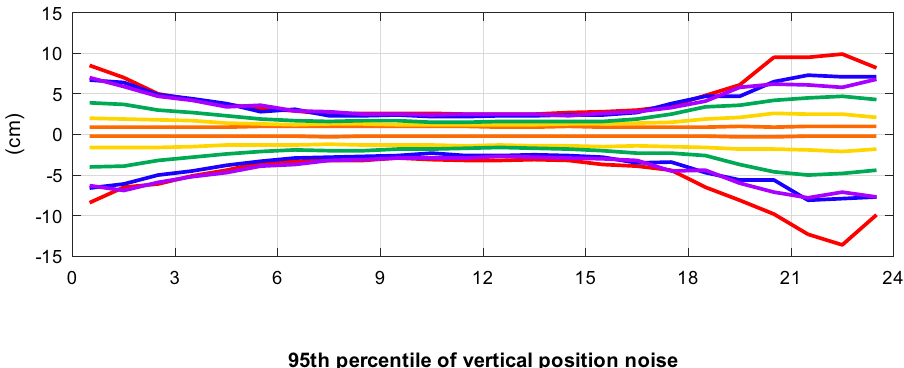
Fig. 4 Statistics as a function of time-of-day. Top panel: 5th and 95th percentile of vertical posi- tion error. Bottom panel: 95th percentile of vertical position noise (standard deviation)